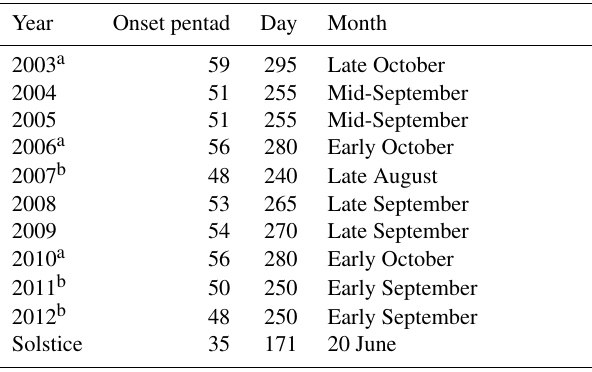
Table 1. Onset pentads between 2003–2012 from GPCP data.